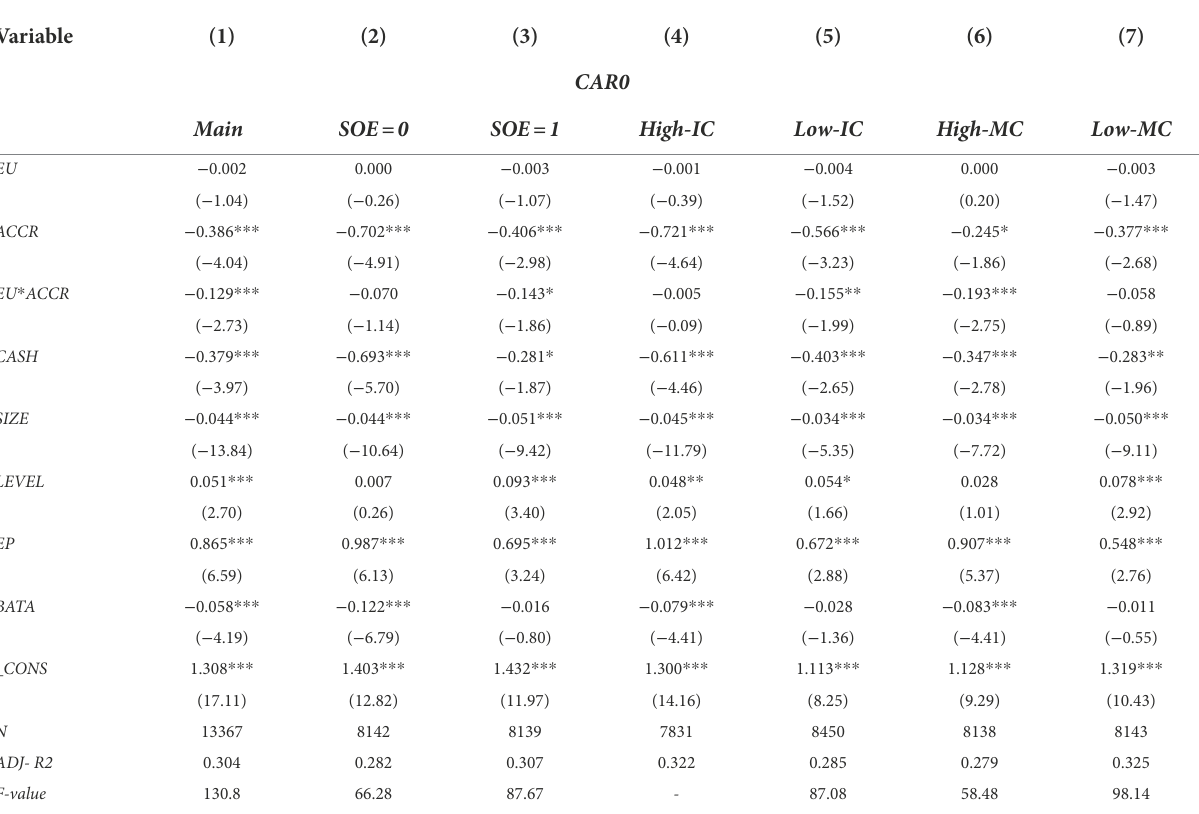
TABLE 8 Robustness test: Substituting the measurement of CAR.